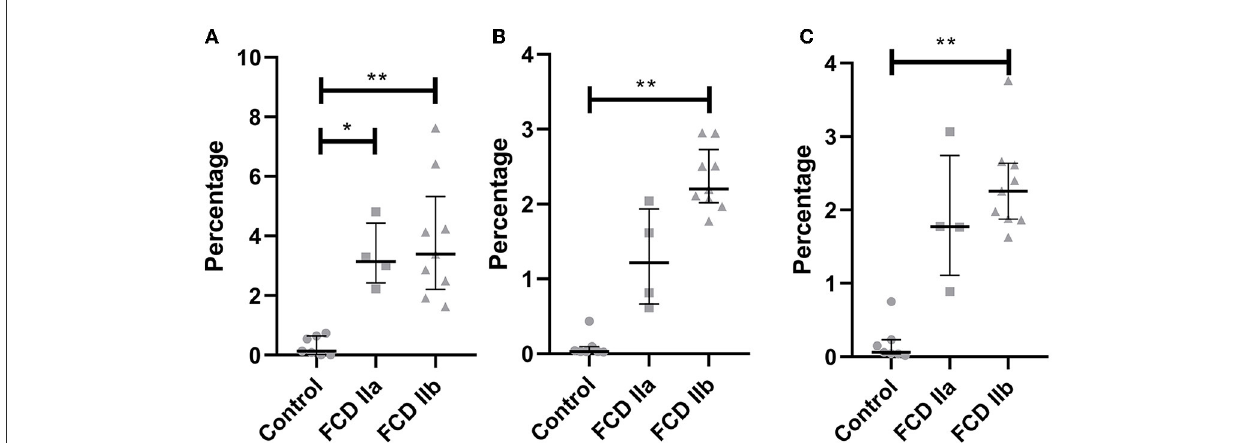
FIGURE7 Quantification of the immunohistochemical expressions (percentage of positive pixels per total number of pixels) of HMGCS1 (A) , HMGCR (B) and SQLE (C) in the gray matter of focal cortical dysplasia and controls. The graphs show scatterplots with superimposed median and interquartile range (25–75). * p < 0.05, ** p < 0.01 (Kruskall-Wallis test followed by Dunn’s post-hoc test).